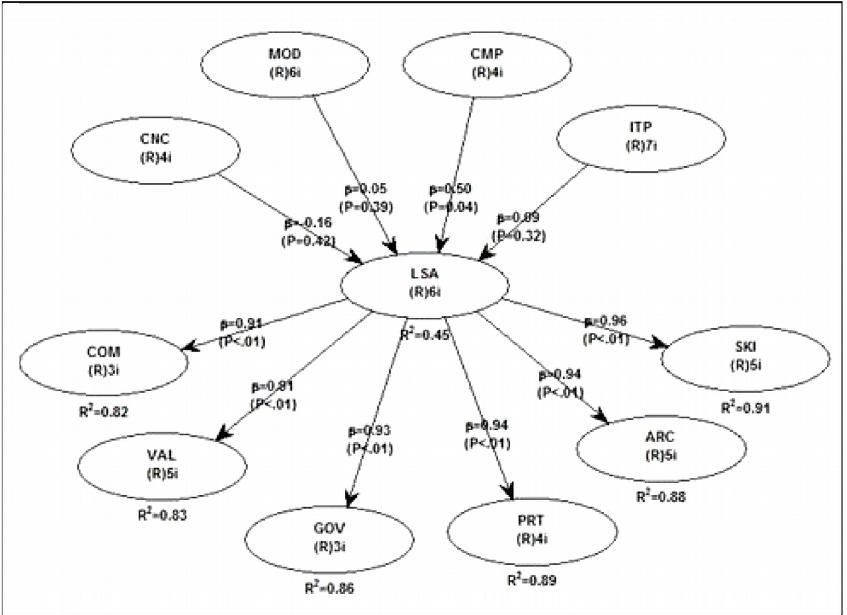
Figure 4. Path coefficient